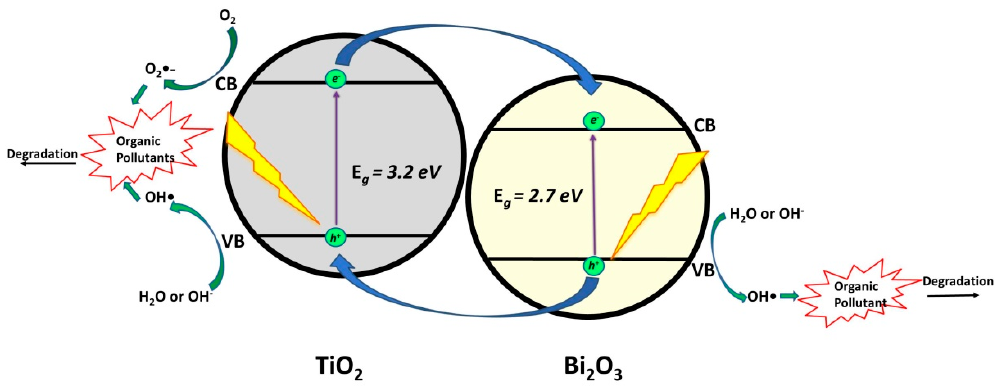
Figure 6. Photocatalytic degradation mechanism over TiO 2 /Bi 2 O 3 composite. Table 4. Photocatalytic degradation of CEC’s over TiO 2 /Cu 2 O composites.